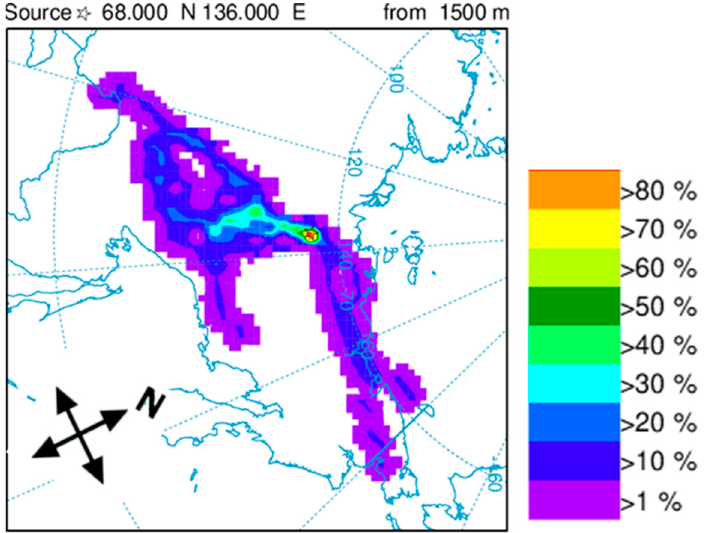
Figure 8. Particle transport probability from fire No. 16 calculated using the Hysplit trajectory model.